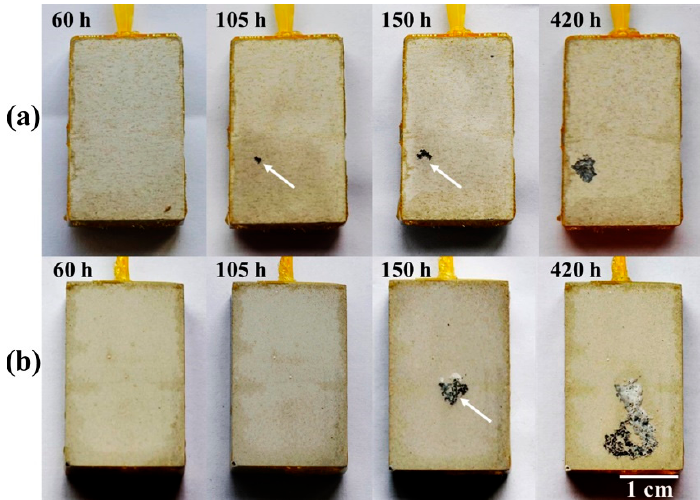
Figure 9. Photographs of the MAO-treated AZ31 ( a ) and AZ91 ( b ) alloys after immersion in 0.1 M NaCl solution for different times.